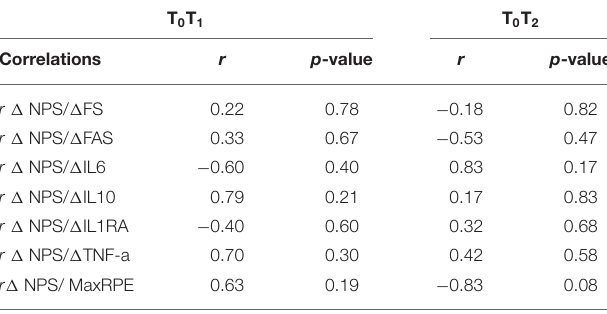
TABLE 6 | Correlations between baseline levels of cytokines and changes in pain for all study participants ( n = 8).